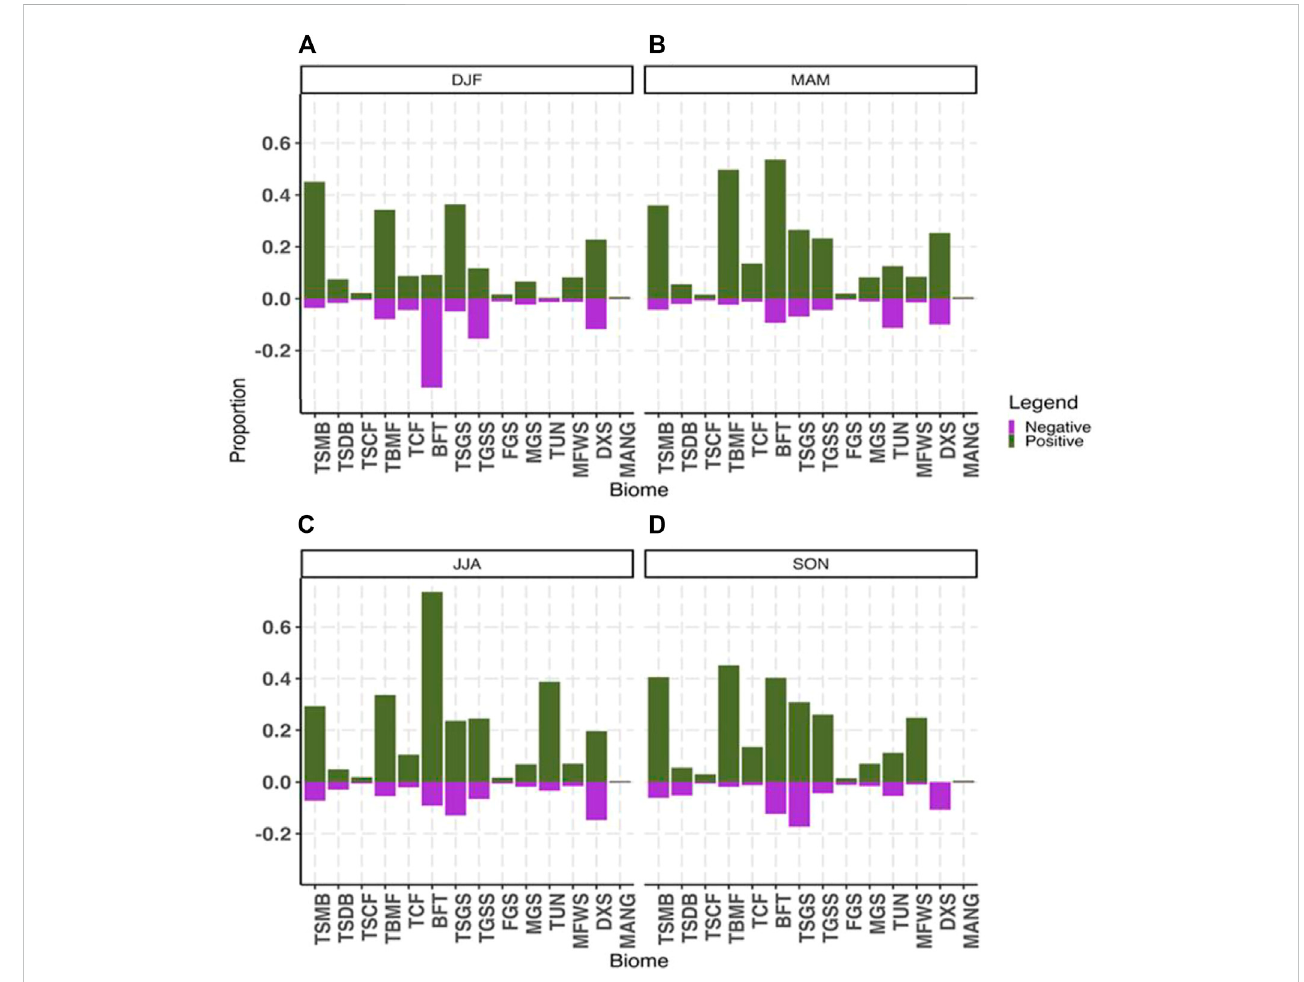
FIGURE 3 Proportion of each biome type globally representing either signi fi cant positive vegetation persistence (green) or signi fi cant negative vegetation persistence (purple) as a function of total pixels in that biome, and shown for all four seasons for (A) December, January, February (DJF); (B) March, April, May (MAM); (C) June, July, August (JJA); and (D) September, October, November (SON). Where acronyms are: TSMB, Tropical Subtropical Moist Broadleaf Forest; TSDB, Tropical Subtropical Dry Broadleaf Forest; TSCF, Tropical Subtropical Coniferous Forest; TBMF, Temperate Broadleaf and Mixed Forest; TCF, Temperate Coniferous Forest; BFT, Boreal Forests-Taiga; TSGS, Tropical Subtropical Grasslands, Savannas, and Shrublands; TGSS, Temperate Grasslands, Savanna, Shrubland; FGS, Flooded Grassland and Savanna; MGS, Montane Grassland and Shrubland; TUN, Tundra; MFWS, Mediterranean Forest, Woodlands, and Scrub; DXS, Deserts and Xeric Shrublands; and MANG,